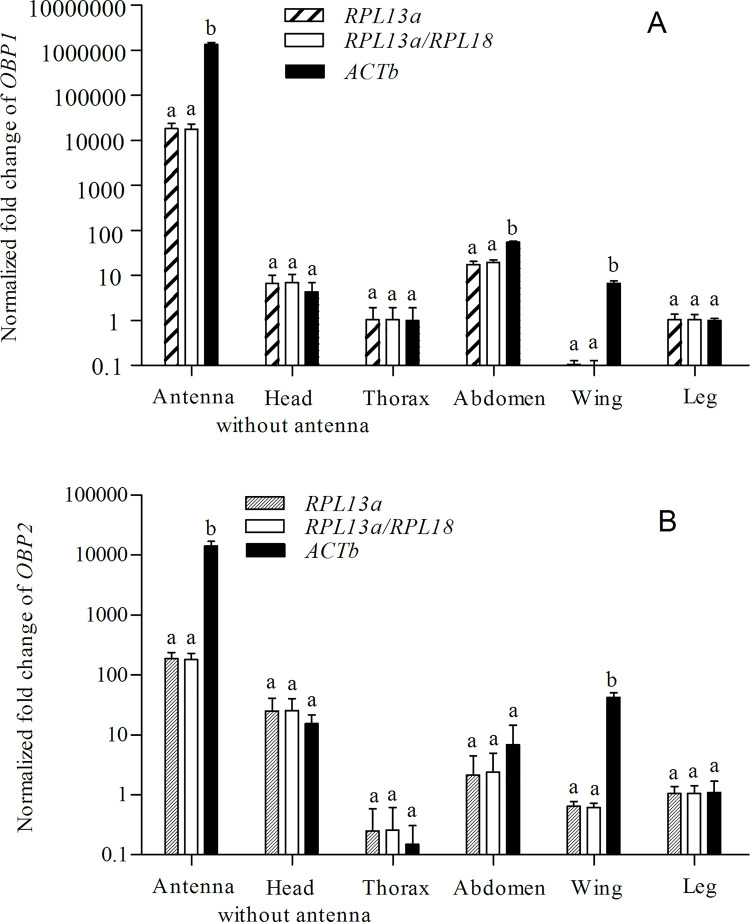
Relative expressions of two odorant-binding protein genes in different tissues normalized by different reference genes.(A) OBP1; (B) OBP2. Values are means ± SD based on three biological replicates. The expression levels of the legs were used as a calibrator to calculate the relative fold change in the different tissues. Different letters mean significant differences (P < 0.05).